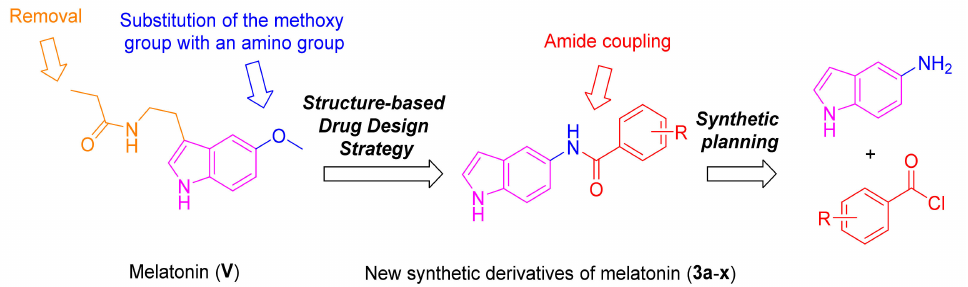
Figure 3. Design of structural modifications performed on melatonin and the synthetic planning to offer derivatives 3a – x